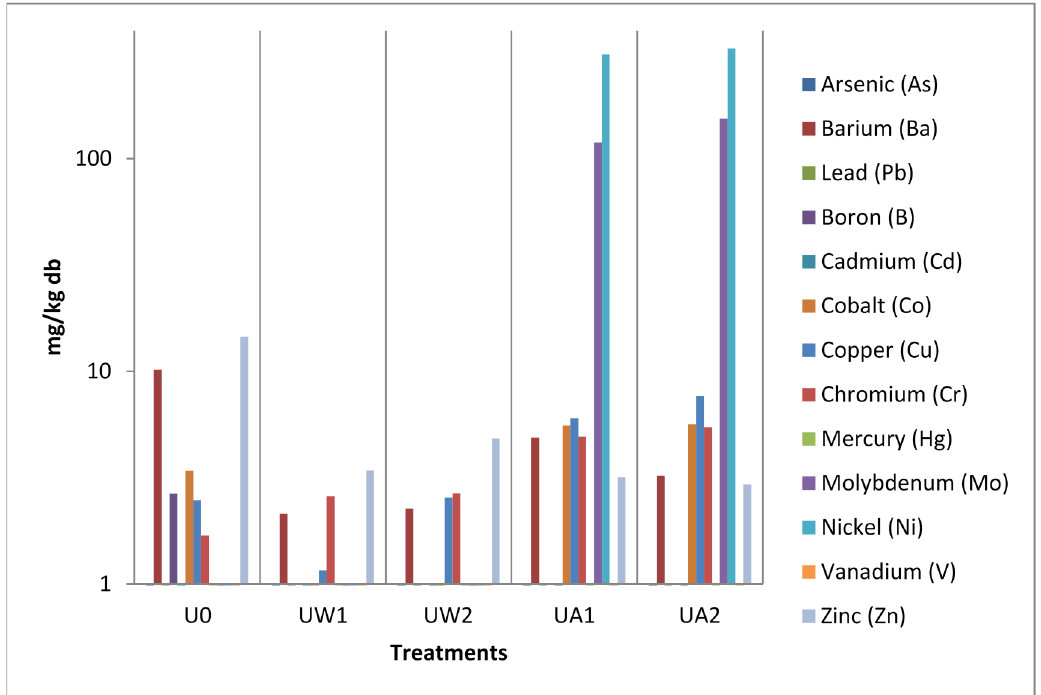
Figure 1. Concentration of heavy metals of untreated and pre-treated